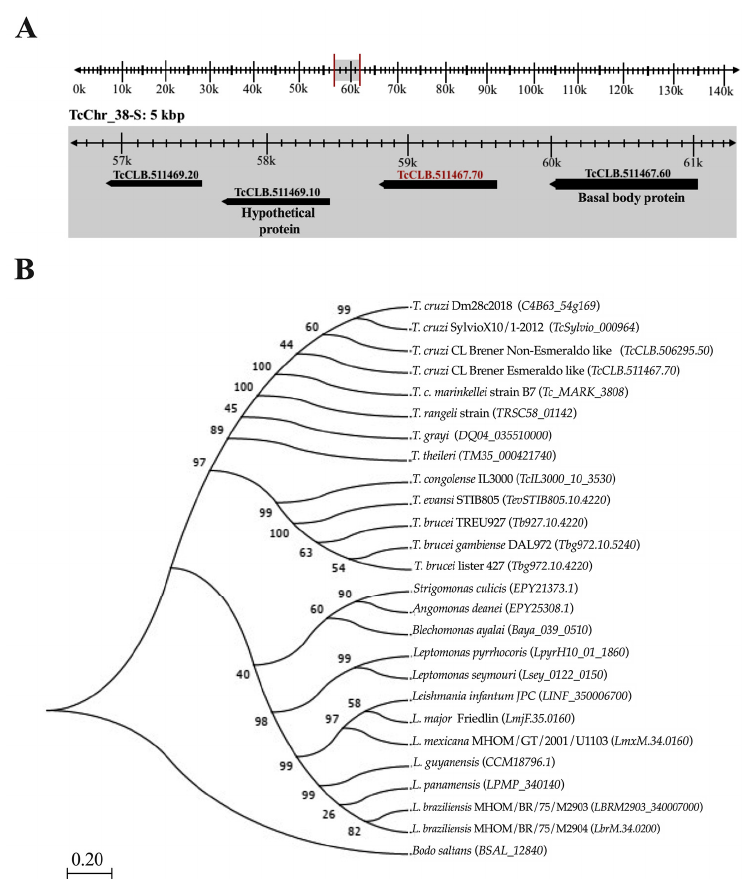
Figure 1. Localization of the gene coding for Tc964 protein in the T. cruzi genome and evolutionary relationship of this protein in different species of trypanosomatids. ( A ) Location of TcCLB.511467.70 gene (red label) on the 38-S chromosome of T. cruzi (TcChr_38S), from curated reference strain CL Brener Esmeraldo like, with the coordinates 58,780 to 59,715k. ( B ) Maximum Likelihood phylogenetic tree proposed to the evolutionary history of the Tc964 protein among taxa of the Trypanosomatidae family; the tree was obtained with the Jones-Taylor-Thornton model using 1000 replicates of Bootstrap and a site coverage cutoff of 75% with the MEGA 7 program [34]. The selected outgroup was the B. saltans species. Numbers at the branches indicate maximum likelihood bootstrap support.